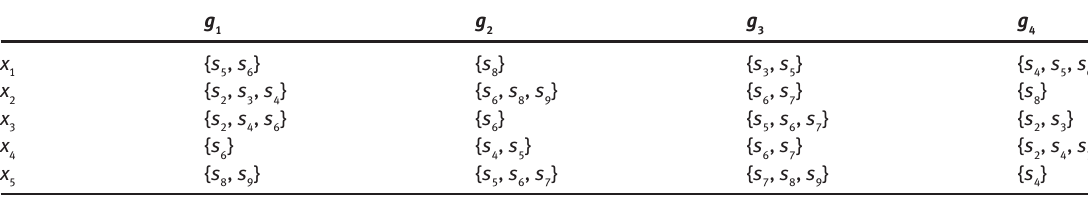
Table 2: Decision Matrix H (2) .